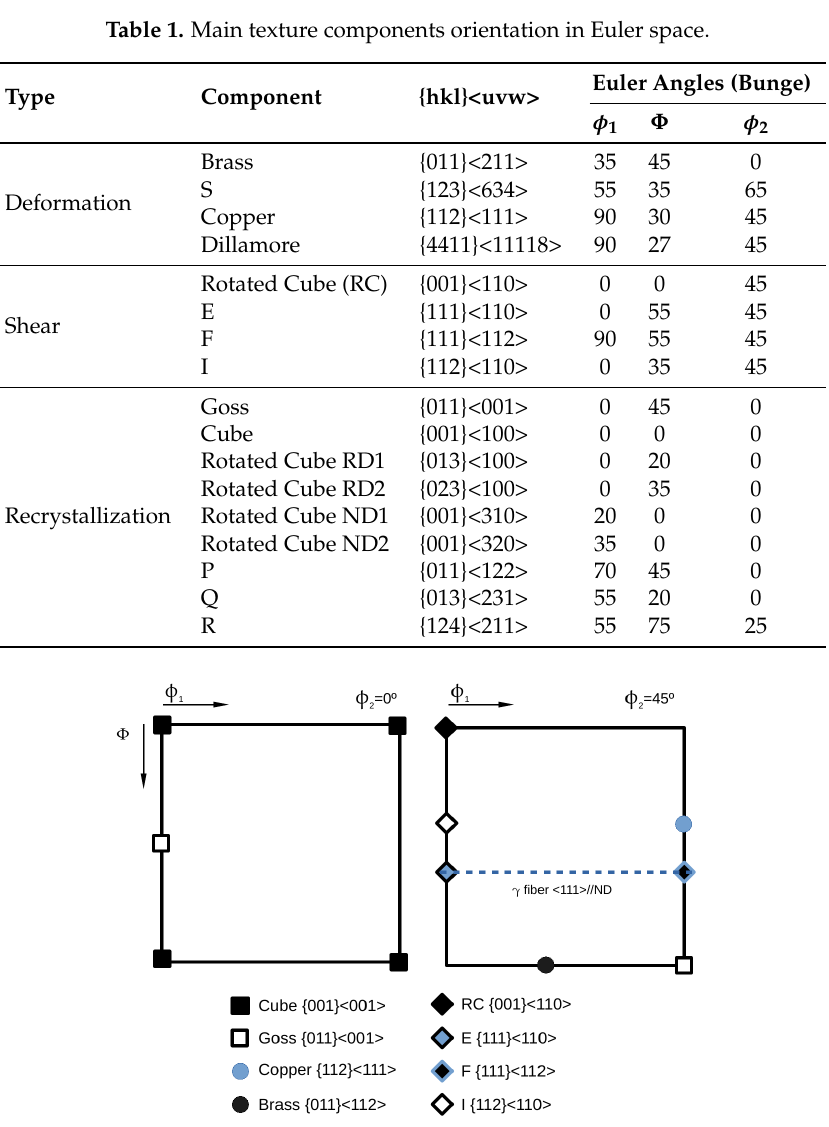
Figure 5. Texture components (selection) representation in Euler